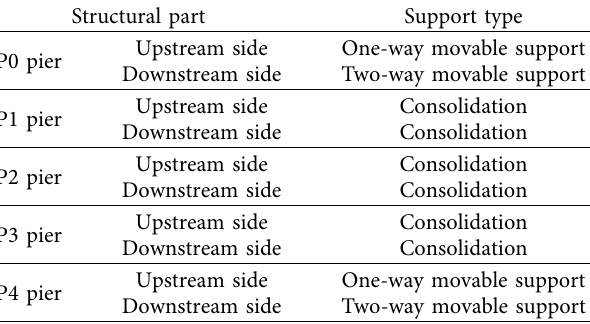
Table 2: Supporting boundary condition.